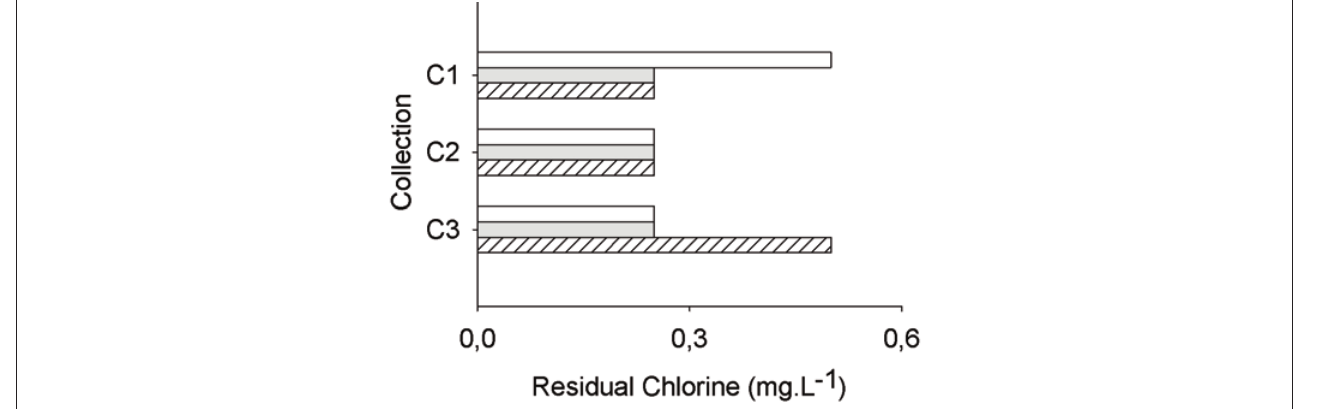
Figure 4 – Residual chlorine concentration of samples collected in the dry period (collections C1 to C3). The white bars show the values obtained for the samples collected at point 1 (inlet chamber), the light gray bars show the values for the samples collected at point 2 (intermediate chamber), and the bars with the striped pattern show the values for the samples collected at point 3 (outlet chamber)